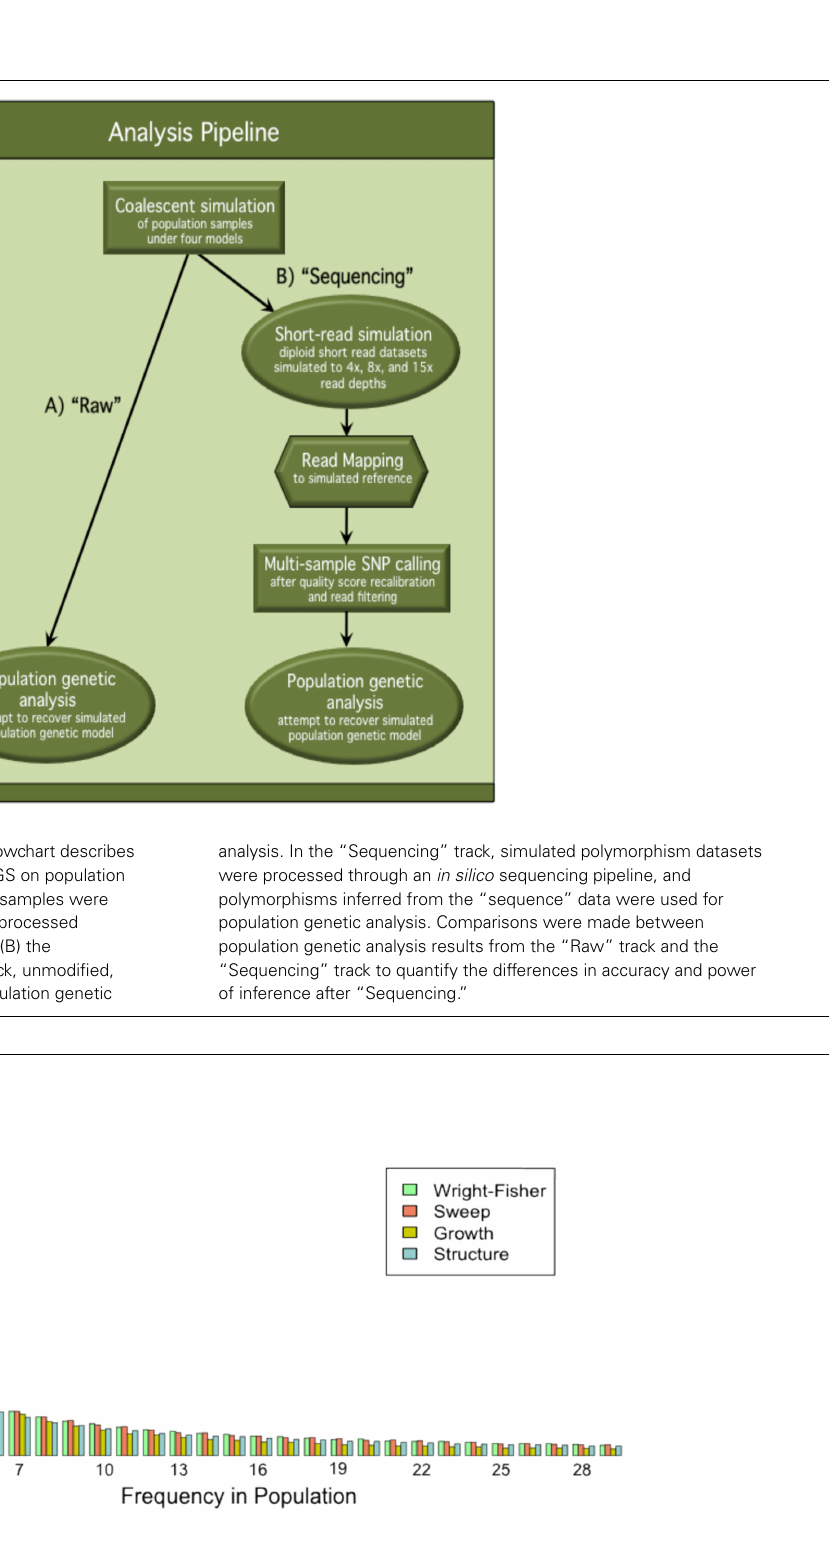
proportions calculated according to that distribution, but only SNPs with frequencies less than 30 are presented here. Data from only one selective sweep model ( α = 1000, τ = 0.005) and one structure model ( F ST = 0.38) are presented